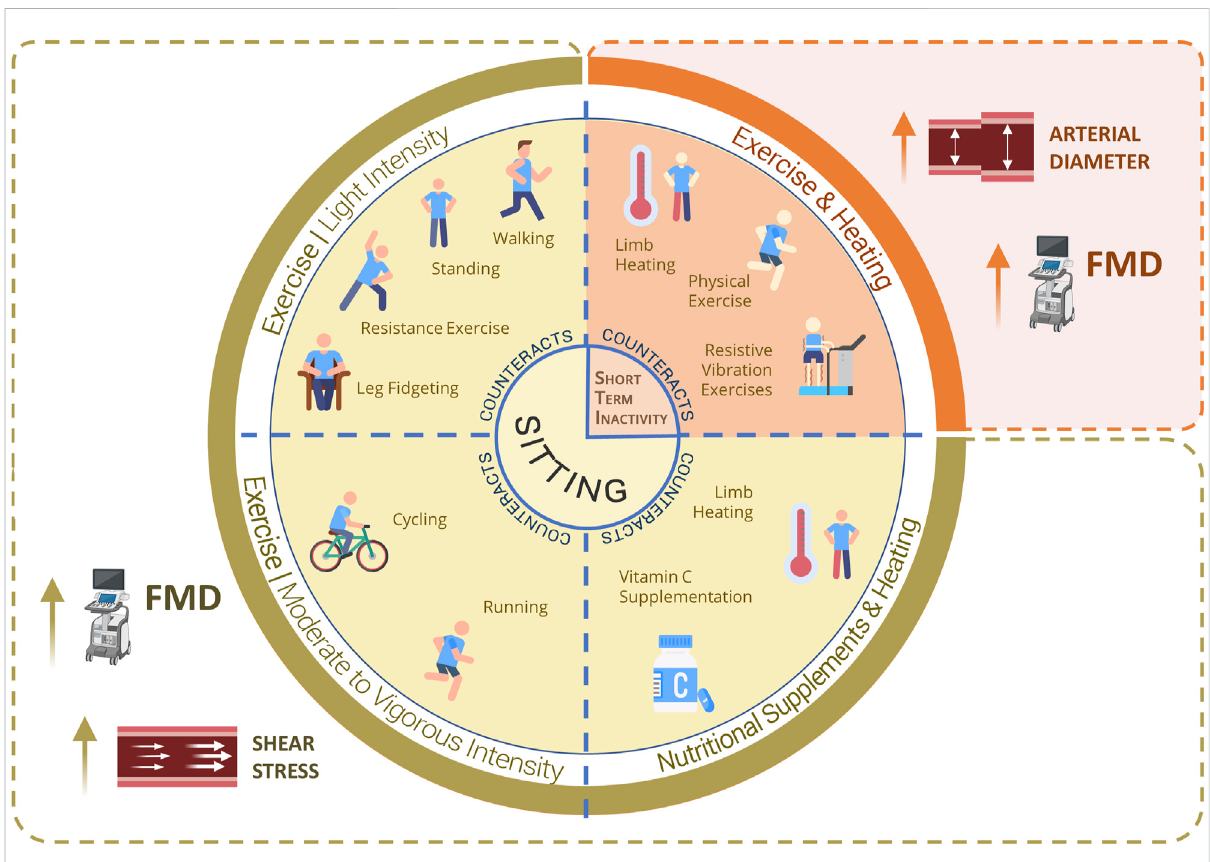
FIGURE 3 Summary of intervention strategies that have been shown to be effective at preventing detrimental effects on vascular health during periods of physical inactivity. Standing, intermittent leg fi dgeting, walking, running, cycling, resistance exercises, limb heating and vitamin C supplementation were shown to be effective at improving FMD and/or shear stress/rate in the context of prolonged sitting. Resistive vibration exercises, limb heating and general physical activity were shown to be effective at preventing declines in FMD and/or arterial diameter during inactivity protocols